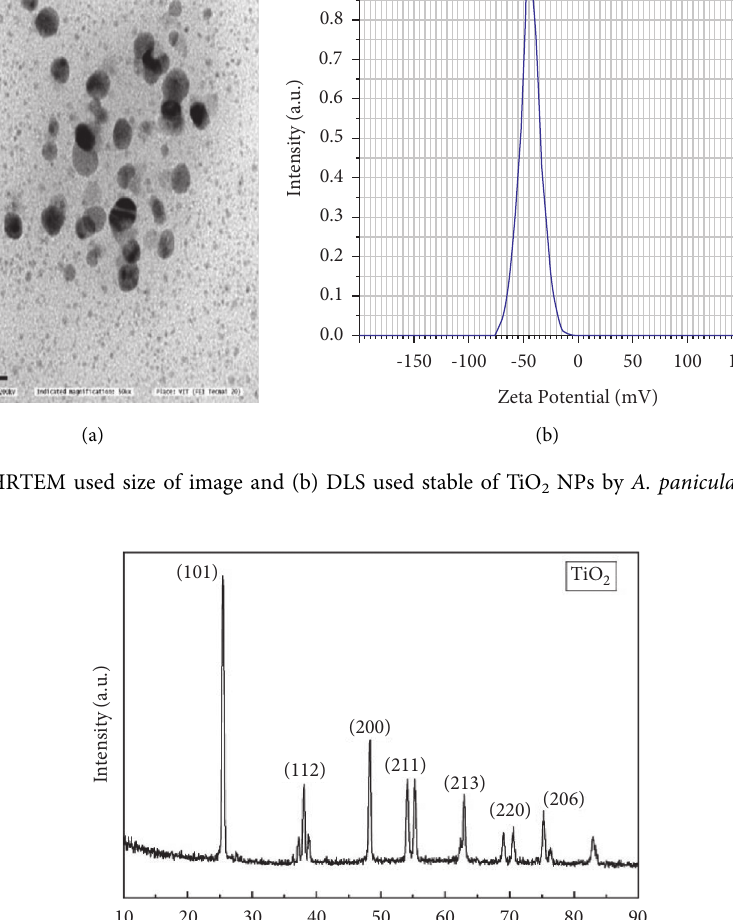
2 NPs by A. paniculata